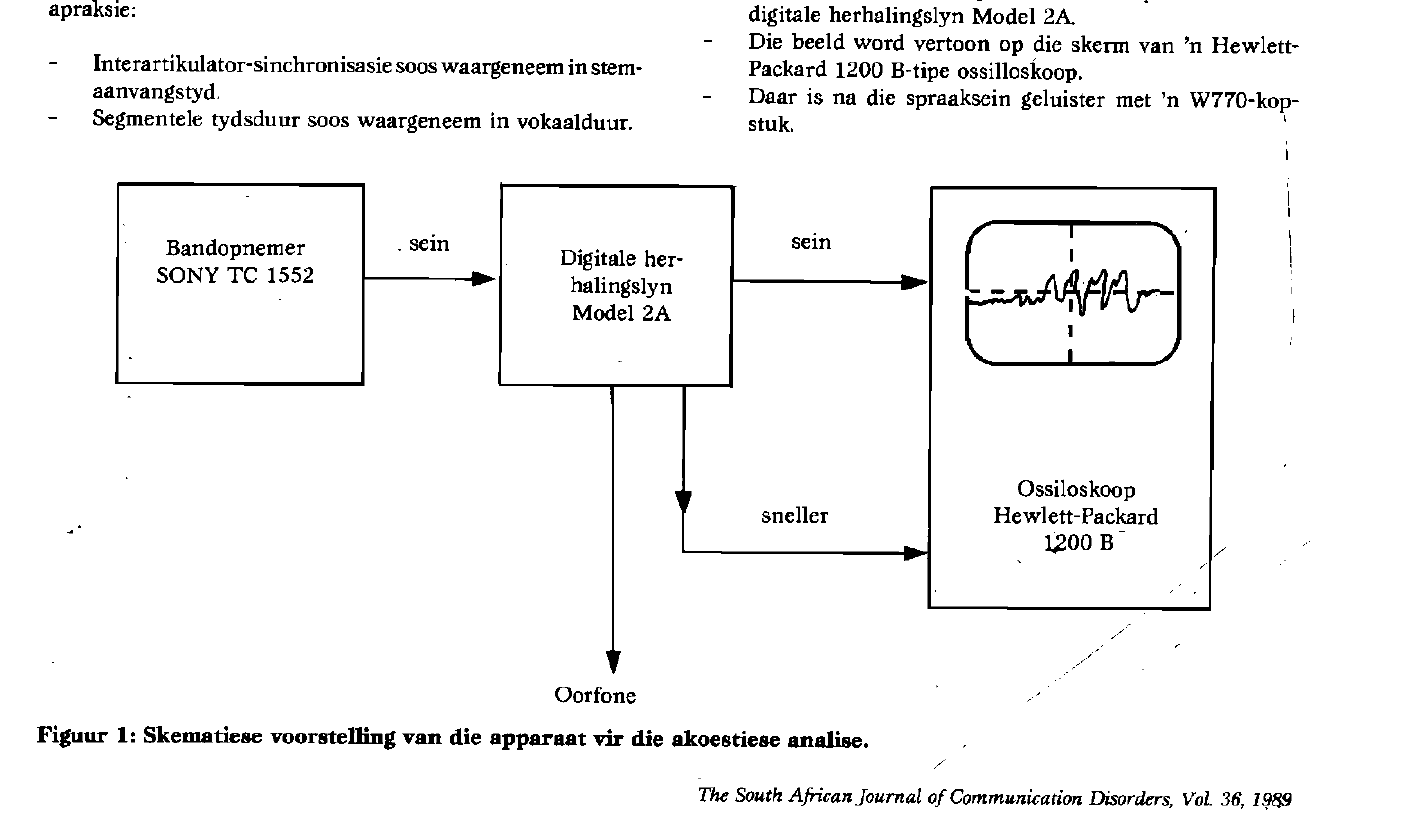
Figuur 1: Skematiese voorstelling van die apparaat vir die akoestiese analise. The South African Journal of Communication Disorders, Vol. 36,